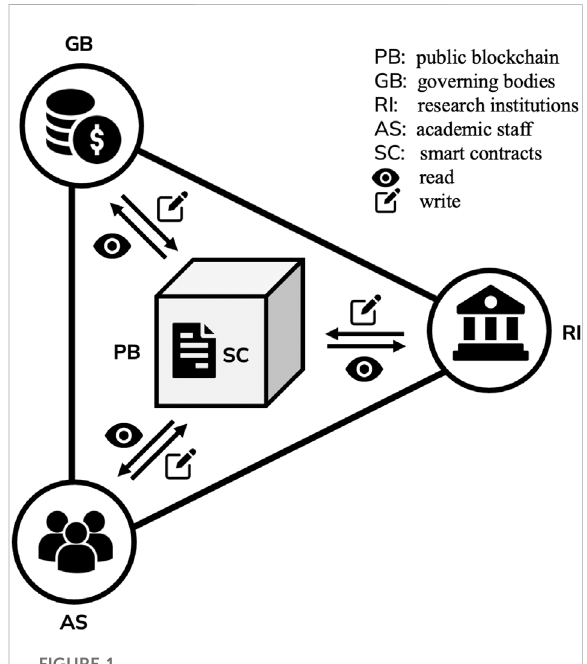
FIGURE 1 Relation between the different participants in the blockchain layer added to the decision-making ecosystem. Research institutions (RI) and governing bodies (GB) cooperatively implement a systemic well-being strategy, which is securely stored and openly accessible on the blockchain network (PB) as smart contracts (SC). The direct experience of the academic staff (AS) is transparently collected by an open-source web-based platform and software oracles which interact with the smart contracts. Individual answers are made pseudo-anonymous and stored on the blockchain network along with the survey outcomes. Data remains openly and securely accessible to the different participants in the